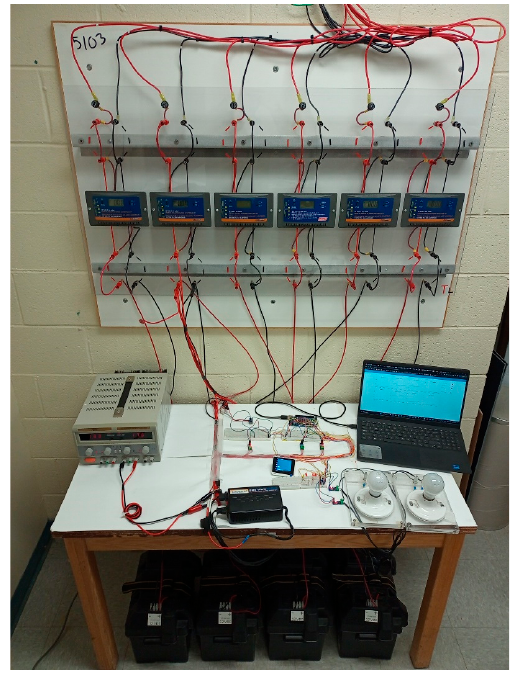
Figure 8. Experimental setup.